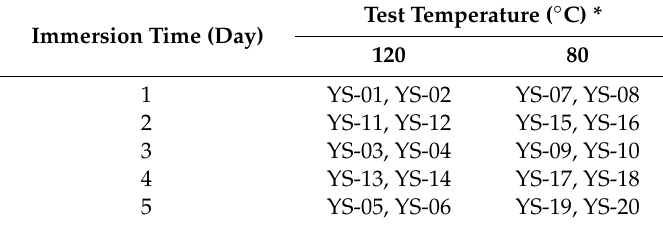
Table 3. Sample information under different saturation time and temperature conditions.